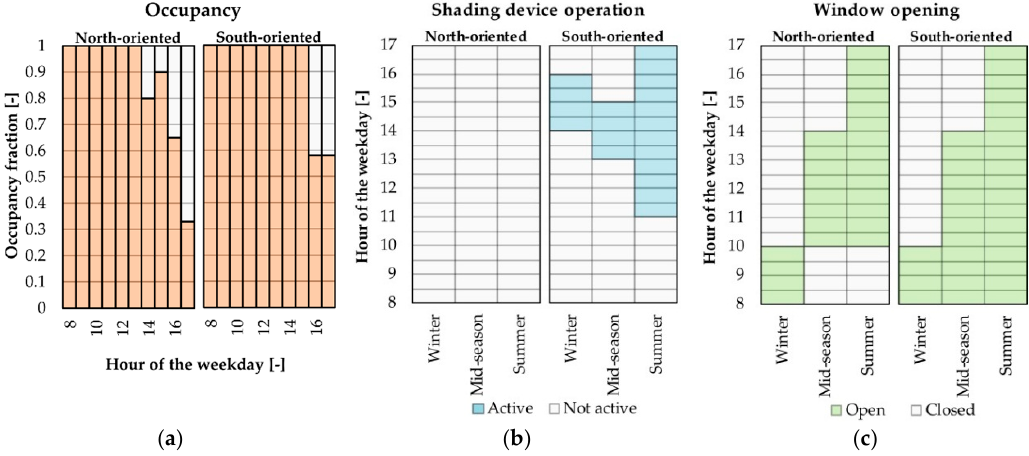
Figure 3. Building usage profiles: ( a ) Occupancy; ( b ) Shading device operation; ( c ) Window opening.